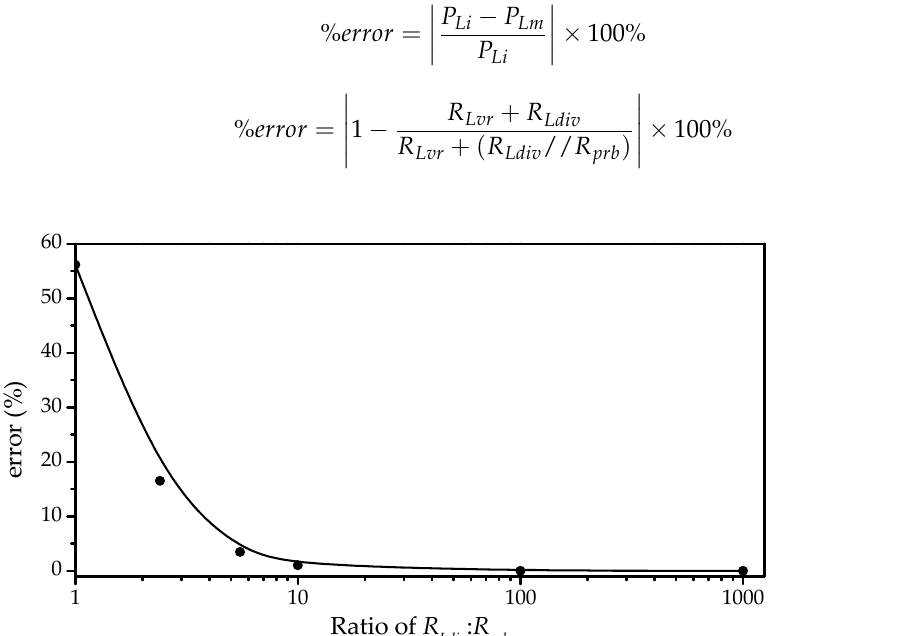
Figure 5. Plot of measurement errors of output power, P L , versus six different ratios (1:1, 1:2, 1:5, 1:10, 1:100, and 1:1000) of voltage-divider resistance R Ldiv to probe resistance R prb .